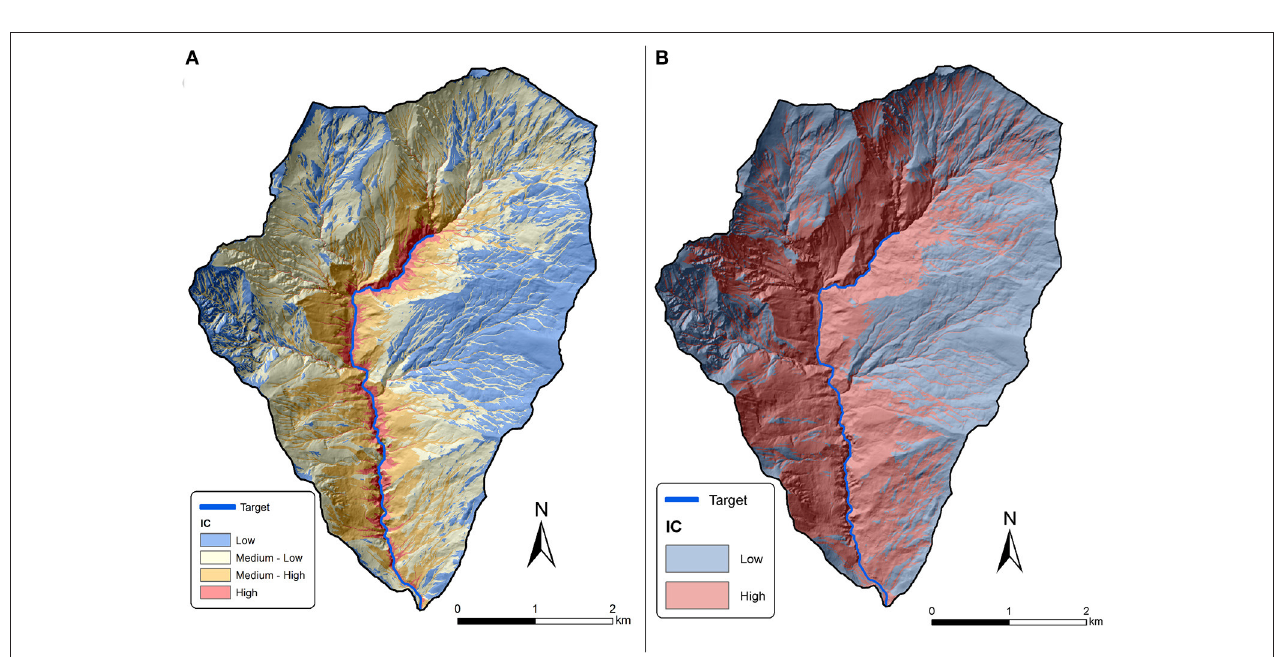
FIGURE 7 | (A) Results of IC analysis with the main river as a target. Results are divided in four classes according to Natural Breaks algorithm. (B) Results of IC analysis grouping the values in two classes.